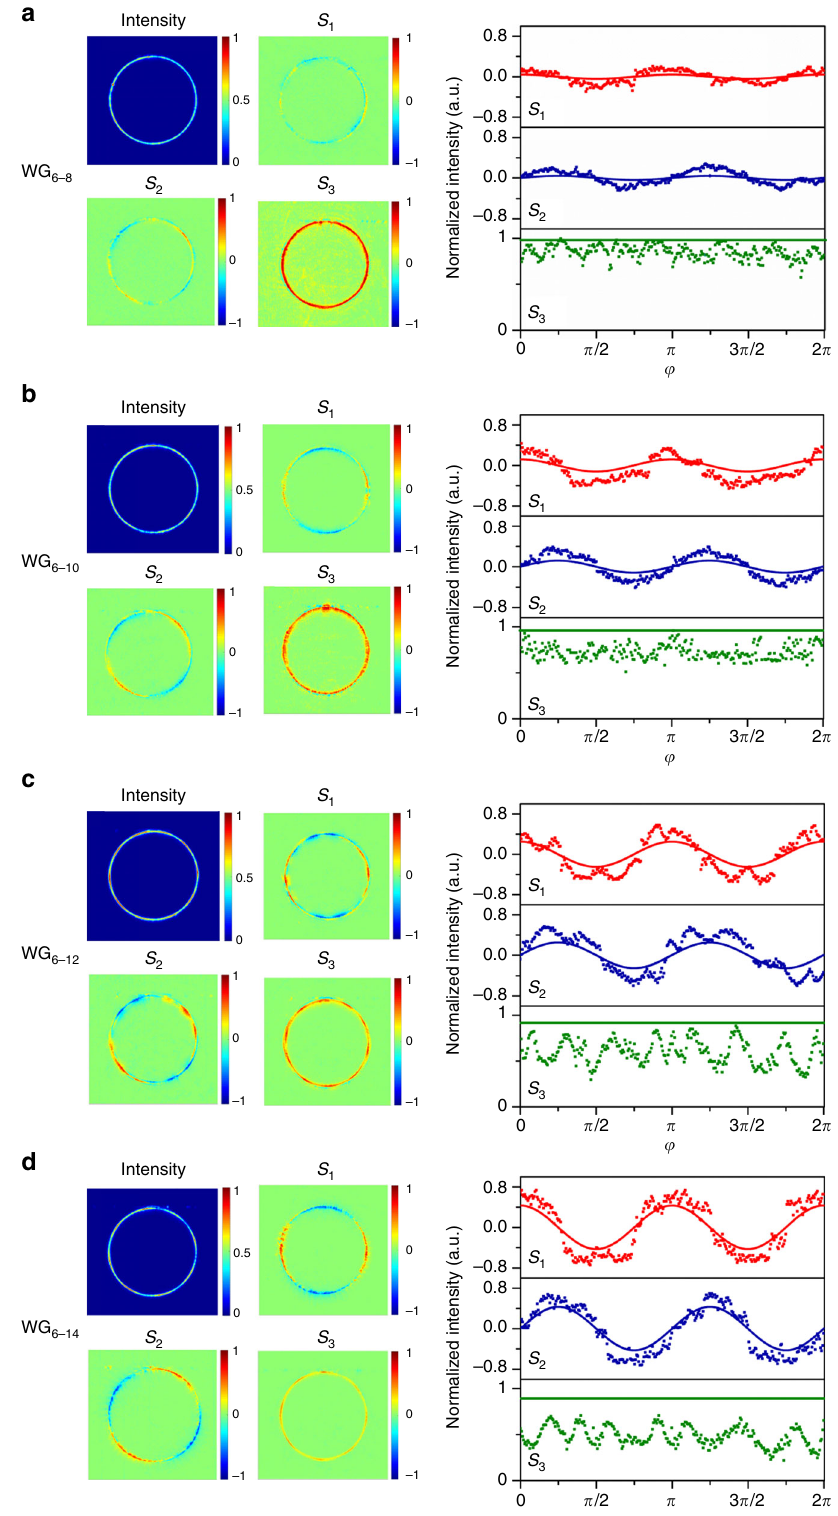
Fig. 5 Stokes polarimetry of near- fi eld polarization of CVVs. a – d Measured two-dimensional maps of near- fi eld Stokes parameters and the comparison with theoretical prediction for devices WG 6 – 8 , WG 6 – 10 , WG 6 – 12 , and WG 6 – 14 , respectively. In each case, the four maps show the measured near- fi eld intensity pro fi le of the device with l TC = + 4, and the normalized Stokes parameters S 1 , S 2 , and S 3 , respectively. The curves in each case show the comparison between the measured results (dots) sampled from the maps and the corresponding prediction (solid curves) from Eq. (7). For each set of measured data, 288 pixels intersecting with the circle of 80 μ m radius along the azimuthal direction ( φ ) from 0 to 2 π are sampled from the corresponding map. For each solid curve, the data are calculated by substituting the transverse-spin state σ from Fig. 3a into Eq.